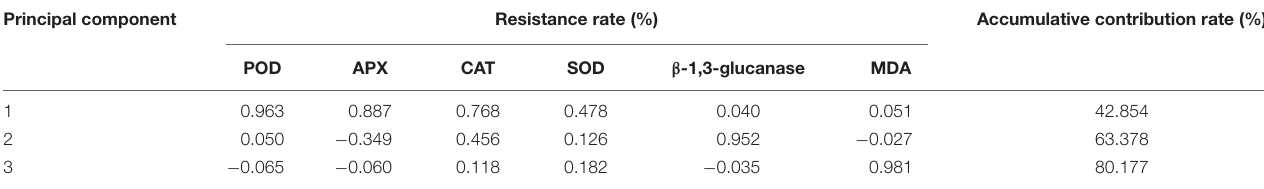
TABLE 4 | Results of principal component analysis.